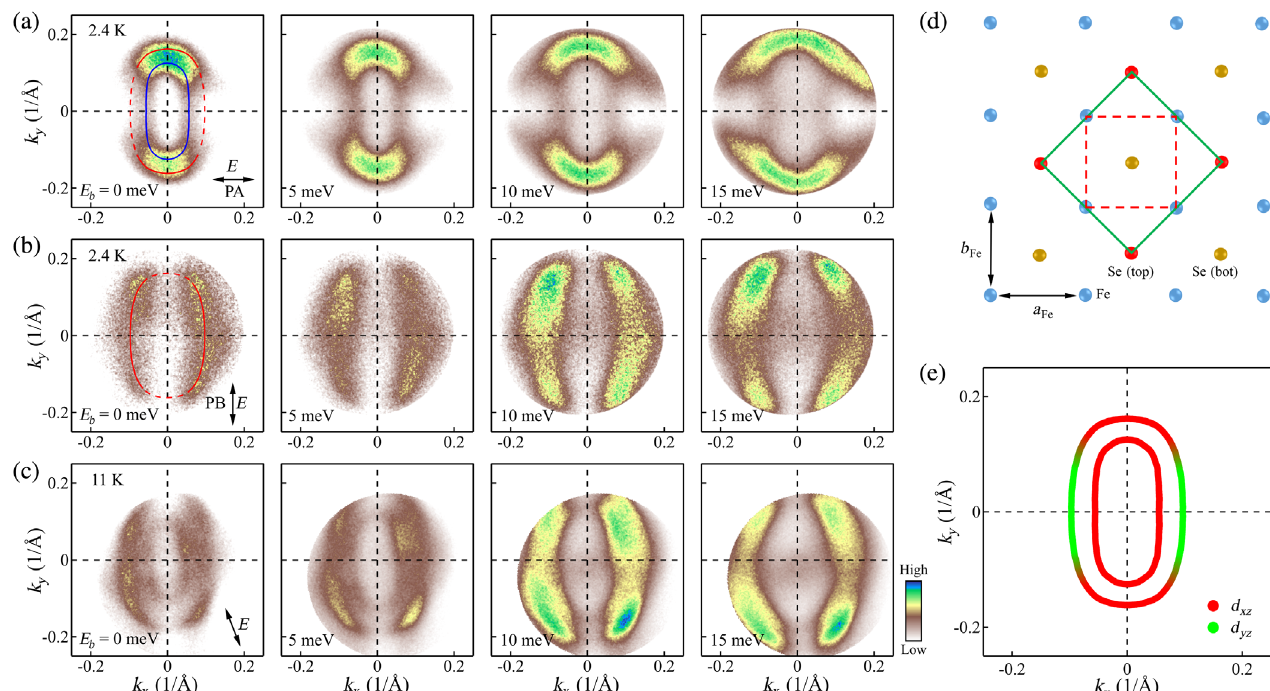
FIG. 1. Observation of two holelike Fermi surface sheets in single-domain FeSe. (a) – (c) Constant energy contours of the single- domain FeSe at 2.4 K under the PA polarization (a), at 2.4 K under the PB polarization (b), and at 11 K under a mixed polarization (c). The direction of the electric field vector E corresponding to the three polarization geometries is marked by double arrows in the leftmost panels in (a) – (c). Blue and red ellipses in the leftmost panels are the guide lines of the observed Fermi surface. (d) Top view of FeSe crystal structure. The blue, red, and yellow circles represent Fe atom, Se atom above the Fe plane (Se top), and Se atom below the plane (Se bottom), respectively. The red dashed line represents the 1-Fe unit cell while the green solid line represents 2-Fe unit cell. We define ¼ b the x axis parallel to the a axis and the y axis parallel to the b axis. In the normal state, FeSe has C 4 symmetry with a , but it Fe Fe Fe Fe > b breaks into C 2 symmetry in the nematic state with a . (e) The extracted Fermi surface of FeSe which consists of two holelike Fe Fe Fermi surface sheets around the BZ center. The dominant orbital character of the two Fermi surfaces is also